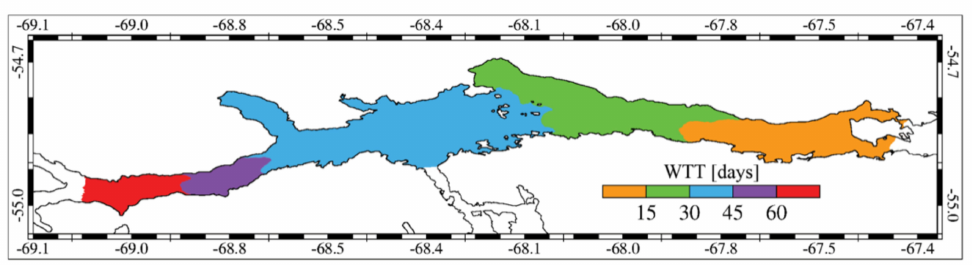
Figure 11. Zonation of the Central BC obtained from the WTT